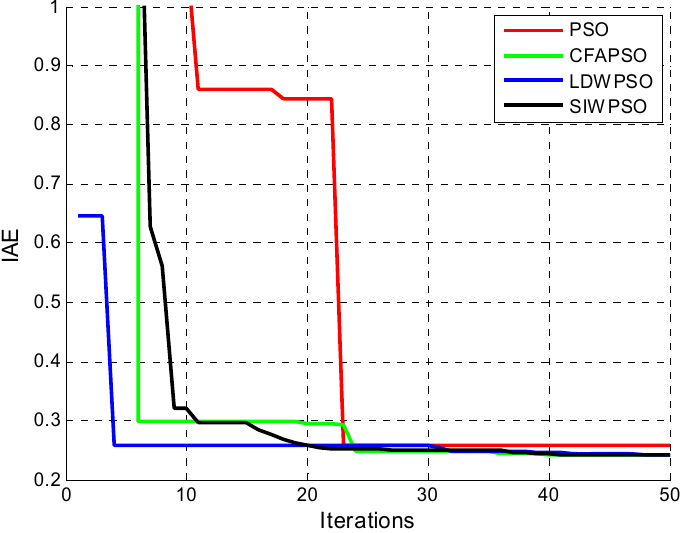
Figure 5. The IAE fitness value obtained by Equation (13) for each iteration of the four PSO